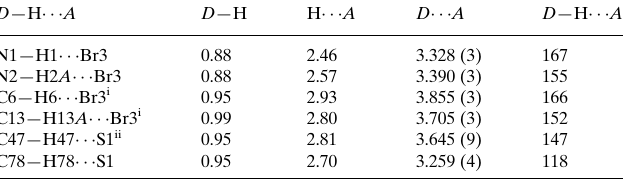
Hydrogen-bond geometry (A˚ , (cid:4)